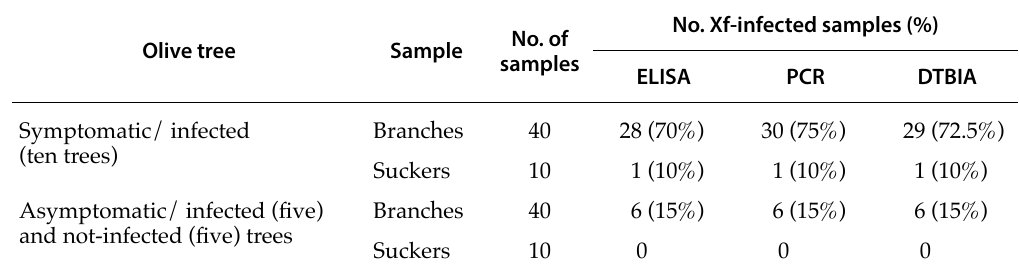
Table 2. Comparative results in the detection of Xylella fastidiosa ( Xf ) in olive branches and suckers by DTBIA, ELISA and PCR. Olive